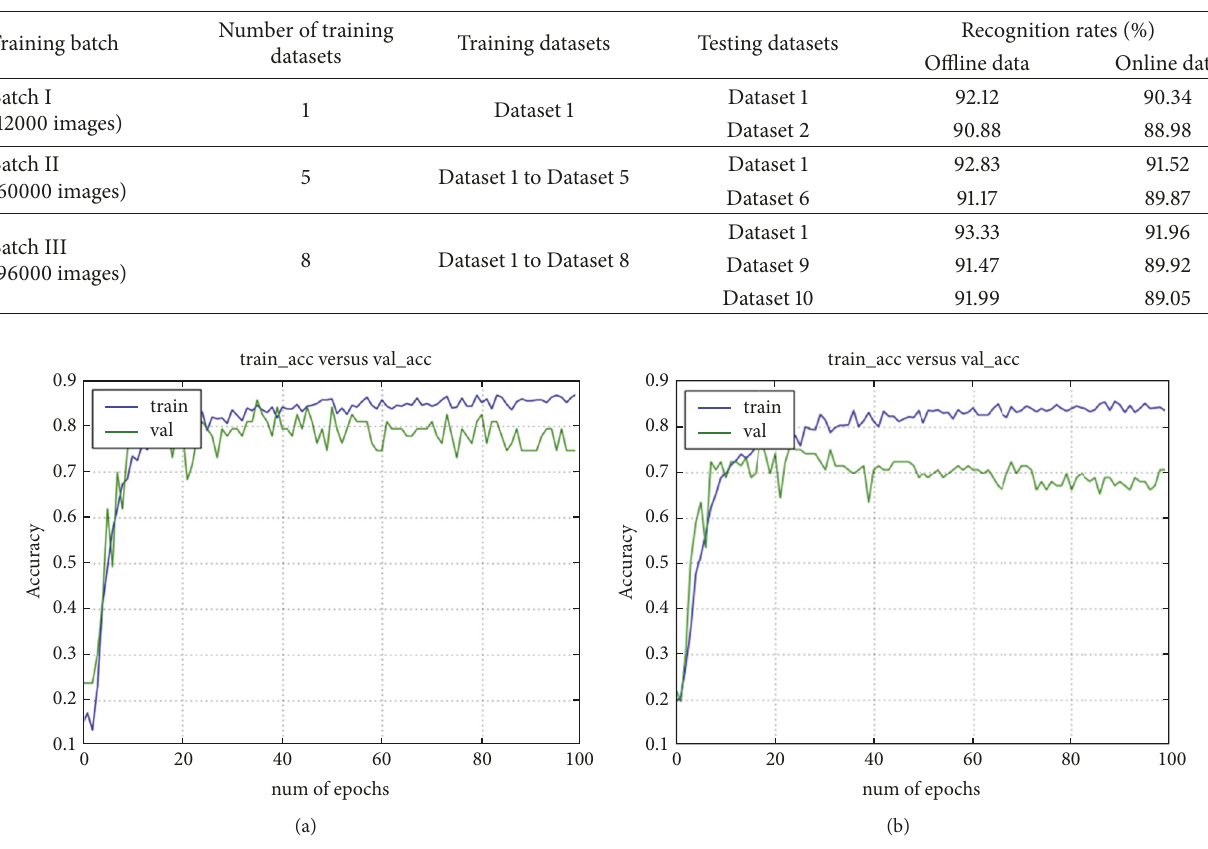
Figure 5: Training accuracy and validation accuracy (a) for offline data and (b) for online